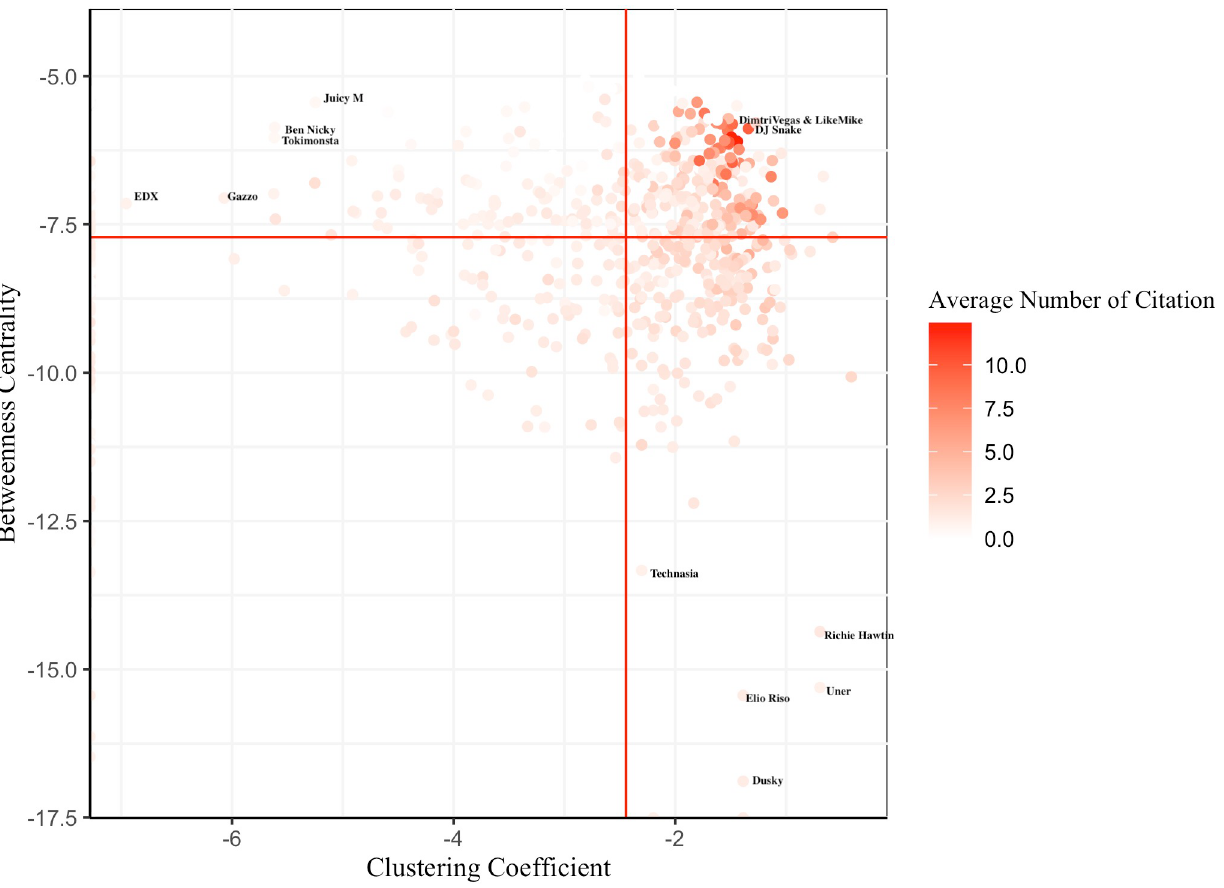
Fig 2. Distribution of DJs by social positions. The axes are the social position variables. We take the log on both social position variables: Betweenness Centrality and Clustering Coefficient. The red lines are the medians of both variables.